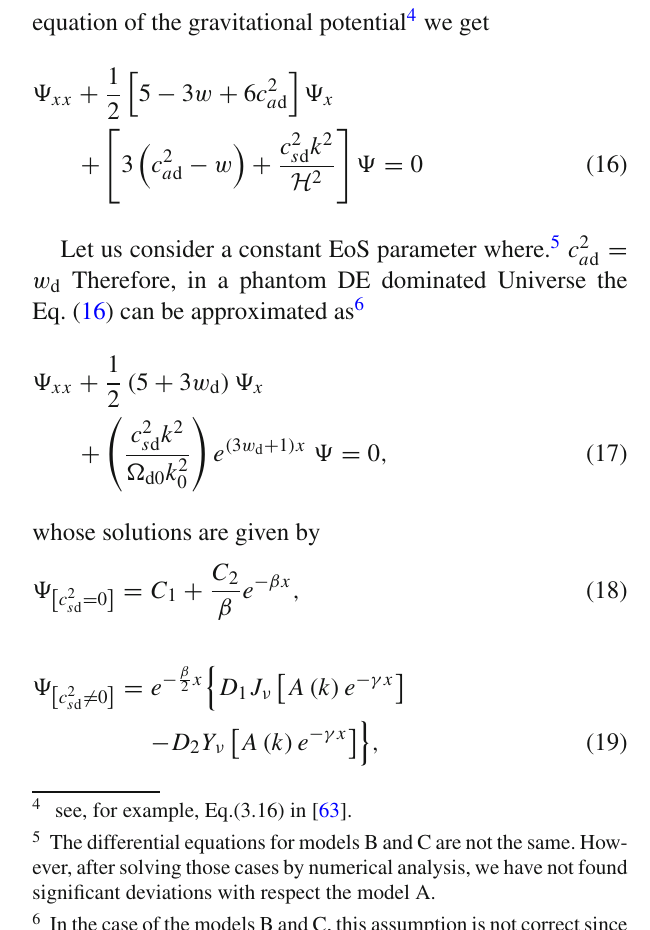
Fig. 4 The left panel of the above figure presents the evolution of the gravitational potential divided by its initial value, (cid:10) (cid:9) . These results cor- respond to model A and choosing a vanishing effective speed of sound = 0. The vertical dashed line corresponds to radiation-matter equal- c 2 s d ity, x ∼ − 8 . 24, while the solid gray vertical line denotes the matter-DE equality, x ∼ − 0 . 27. The range and the numerical value of the modes